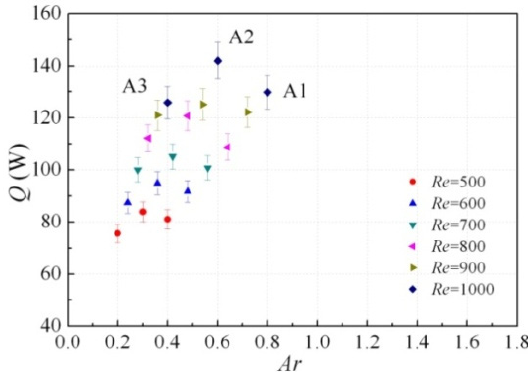
Figure 13. Heat transfer rate variation with A r , Va = 250.